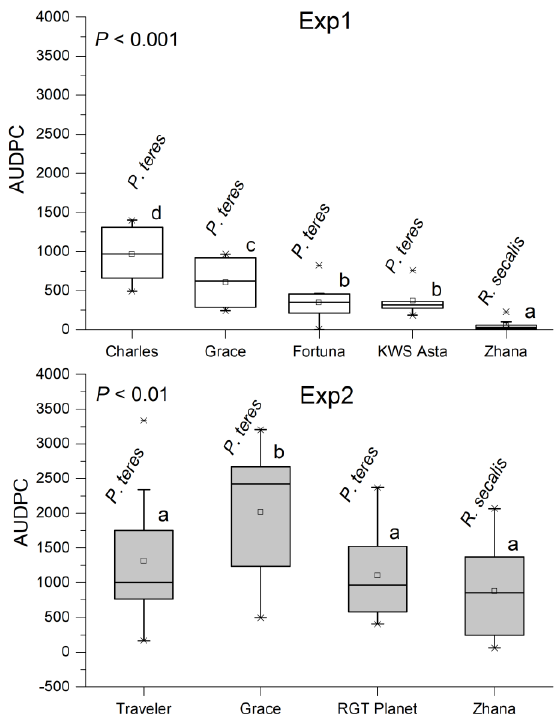
Figure 4. Malt barley cultivars’ susceptibility to Pyrenophora teres f. teres (net form net blotch—NFNB) and Rhynchosporium secalis (leaf blotch and scald) based on the area under disease progress curve (AUDPC). Broad lines are medians, square open dots are means, boxes show the interquartile ranges, and whiskers extend to the last data points within 1.5 times the interquartile ranges. p -values of ANOVA and permutation tests are given. Groups not sharing the same letter are significantly different according to LSD test ( p < 0.05). Table 1. ANOVA summary for grain yield (GY), grain protein content (GPC), maltable (% grains > 2.2 mm), AUDPC and disease severity during the onset of stem elongation (DS SE ) and grain filling (DS GF ) phases.